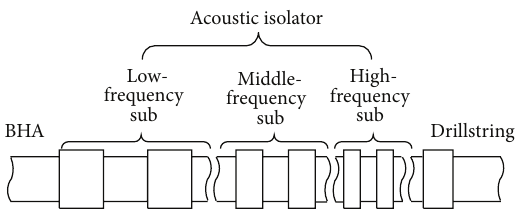
Figure 5: Structure diagram of a combined acoustic